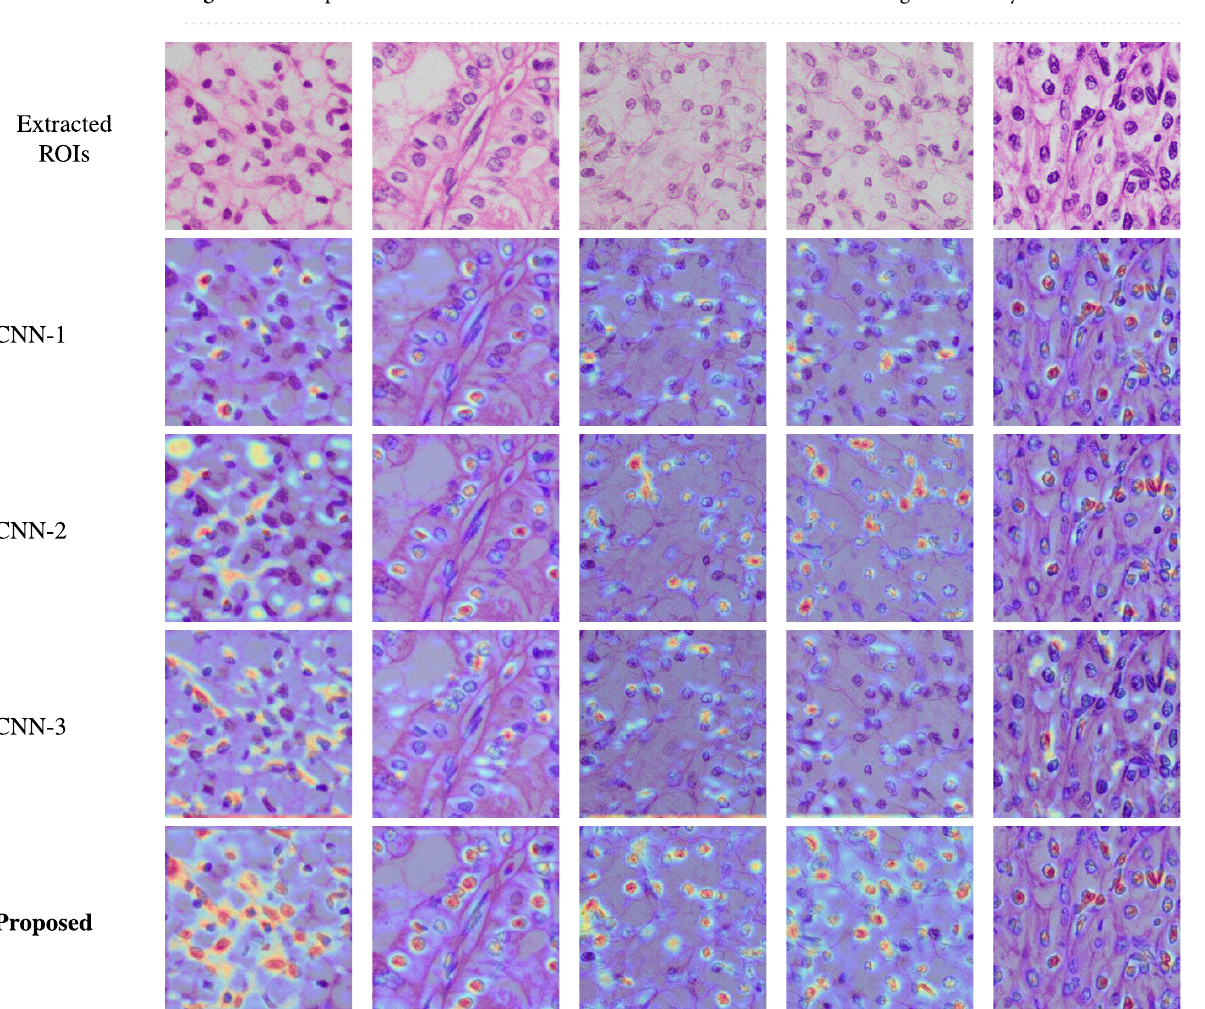
Figure 5. Comparison of intermediate features with and without channel sharing between layers.